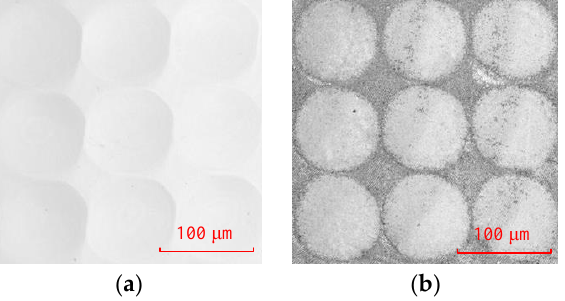
Figure 24. Microscope images of microlens arrays: ( a ) microlens arrays on the mold and ( b ) microlens arrays on the ChG.